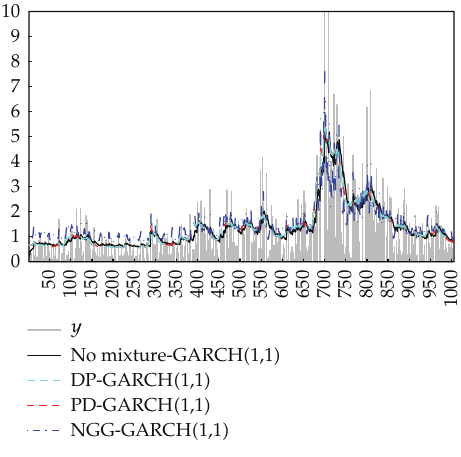
Figure 1: Volatility